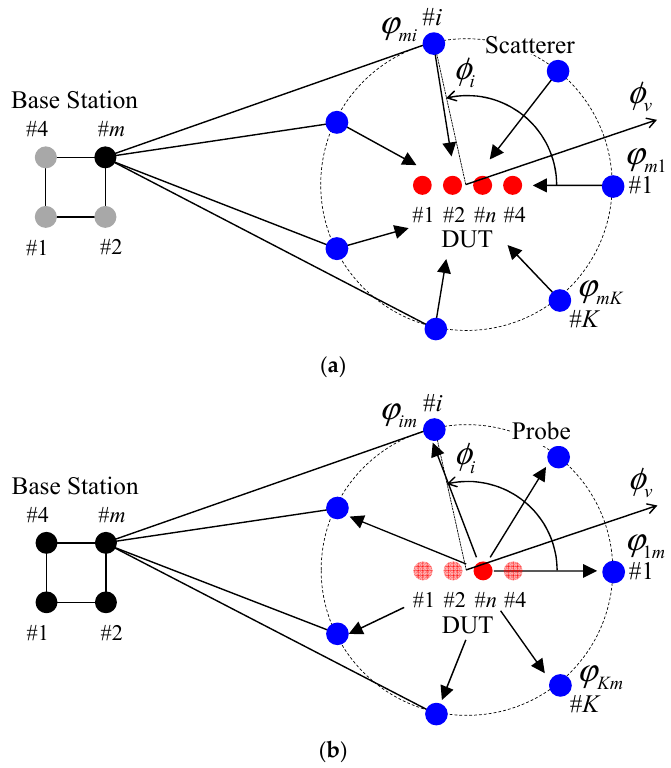
Figure 2. Two-dimensional channel model: ( a ) downlink; ( b ) uplink.